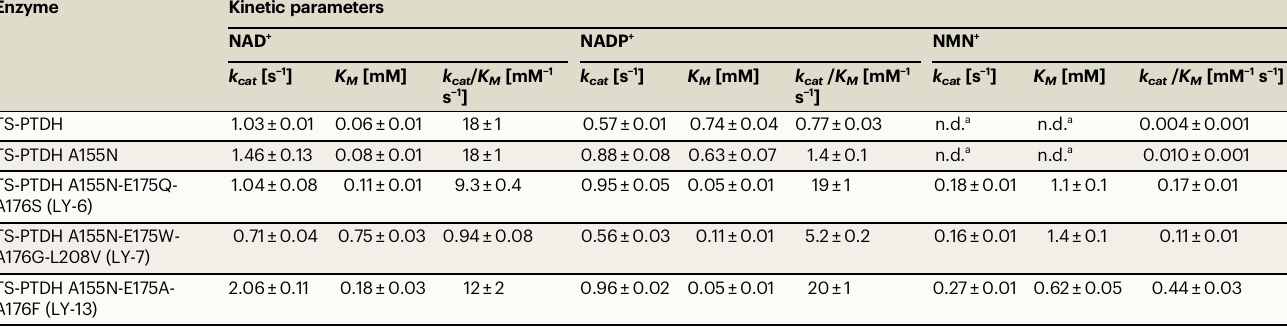
Table 1 | Kinetic parameters of PTDH variants Enzyme Kinetic parameters